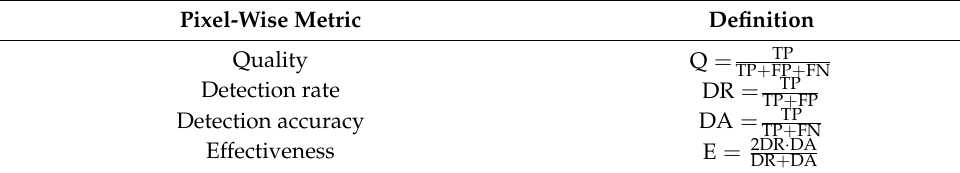
Table 2. Definition of